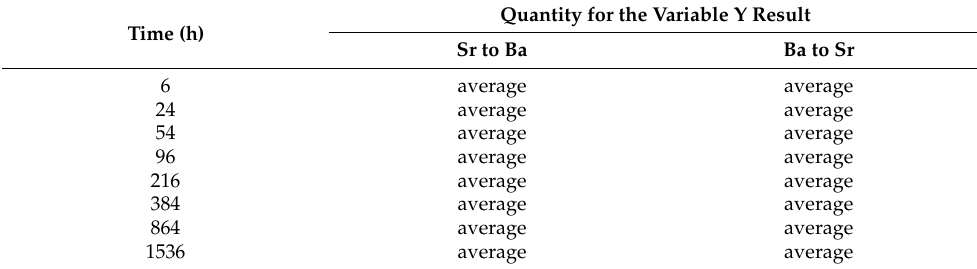
Table 8. Summary of fuzzy-inference results in relation to the leaching of Ba and Sr from the opoka rock for all considered time steps.